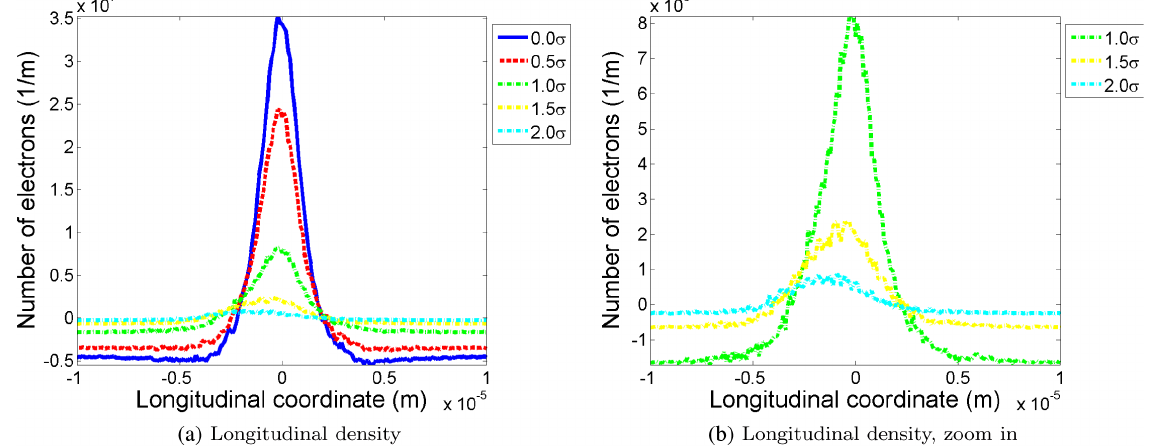
FIG. 15. Longitudinal density modulation at the end of the modulator by stationary ion with various displacements from the axis in x direction.